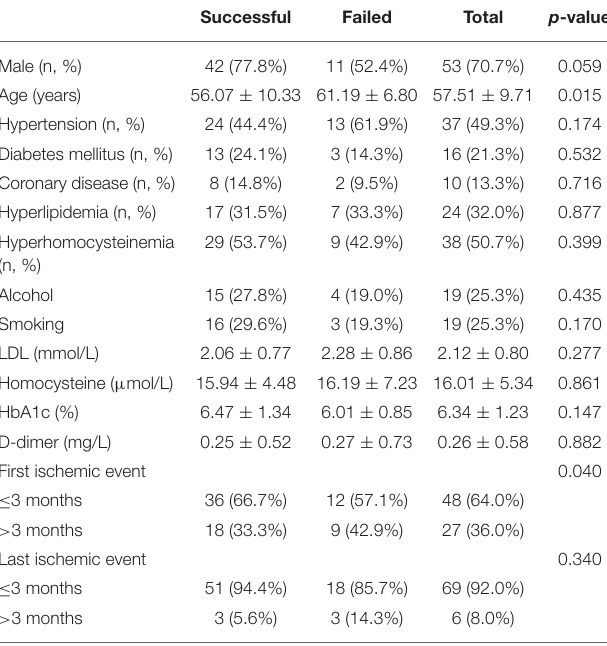
TABLE 1 | Basic characteristics of the patients.